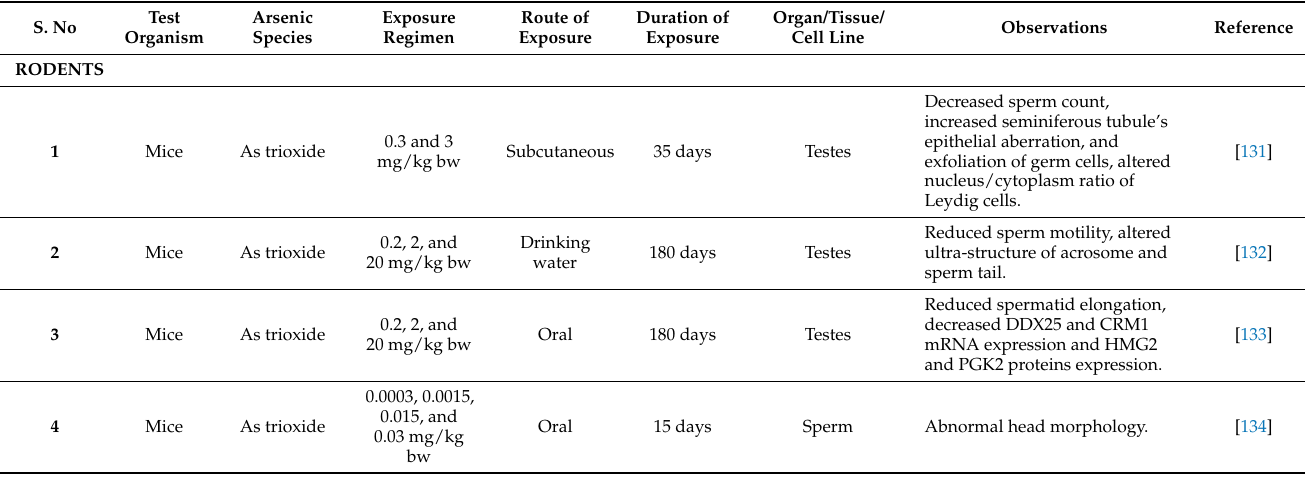
Table 3. Preclinical and cell line studies show that arsenic causes reproductive toxicity and alters testicular